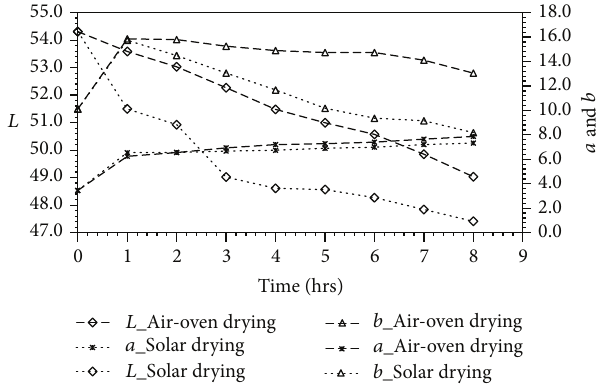
Figure 2: Color profile of shrimp meat during